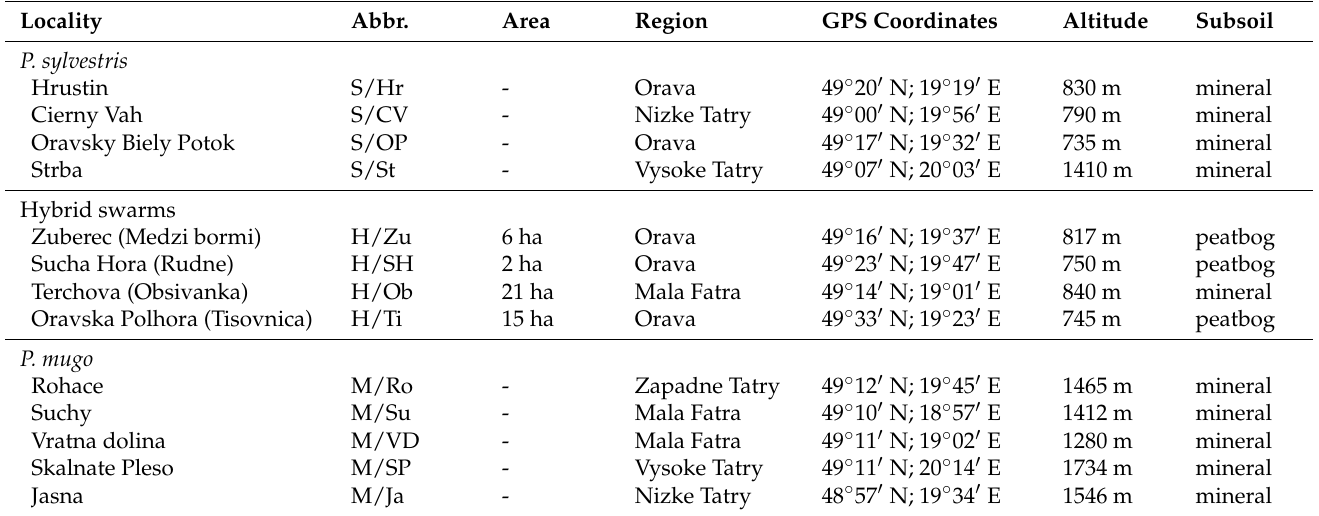
Table 1. List of populations used in